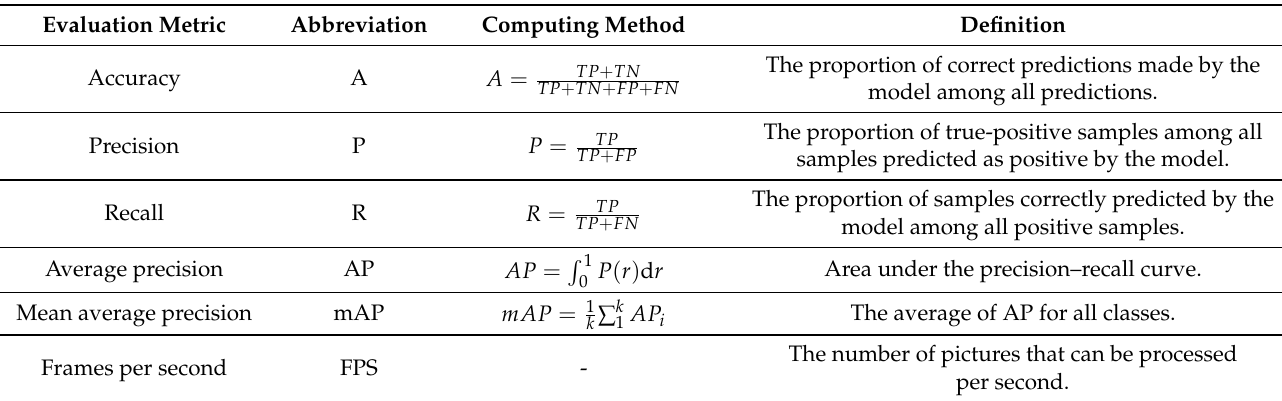
Figure 5. Precision–recall curve. Table 2. Commonly used model evaluation